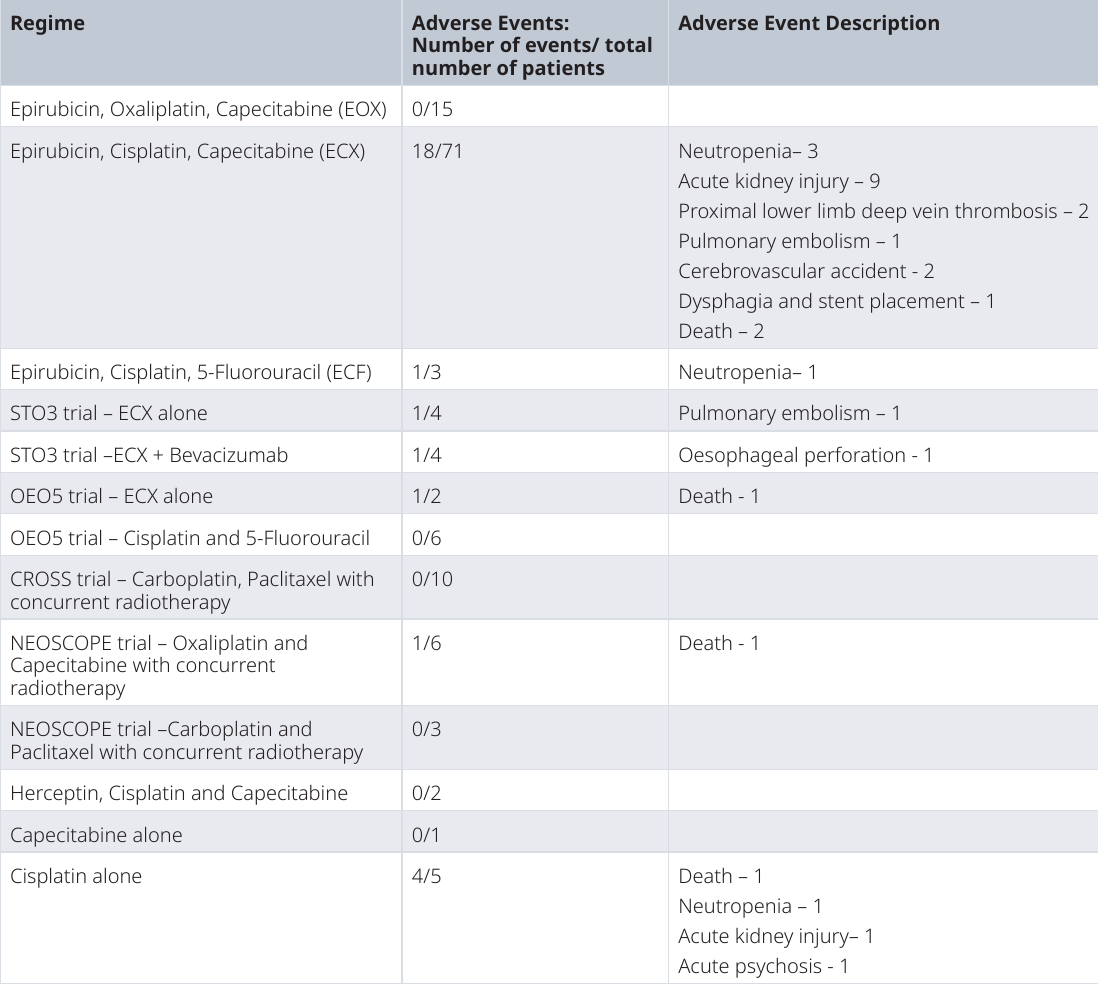
Table 6. Adverse events during chemotherapy and chemoradiotherapy – events of grade ≥ 2 during chemotherapy or chemoradiotherapy.